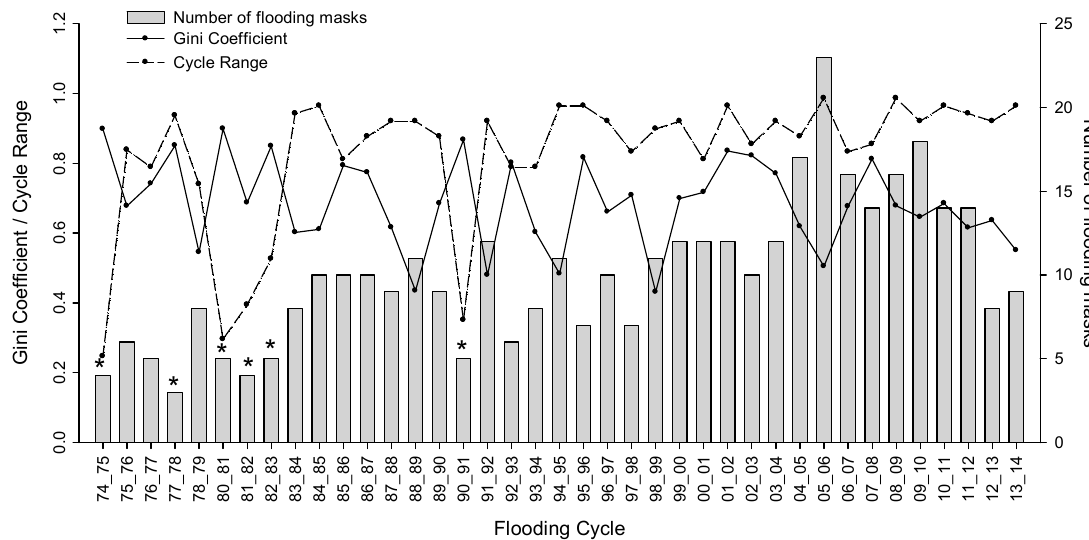
Figure 5. Number of total available flooding masks per flooding cycle. Gini coefficients are also depicted (solid line), pointing up the uniform distribution of flooding masks for every flooding cycle (high values indicate uneven distribution of available flooding masks). Cycle range values are also shown (dotted line), revealing the time span between the earliest and latest flooding masks. Asterisks indicate the discarded cycles for time series analysis.